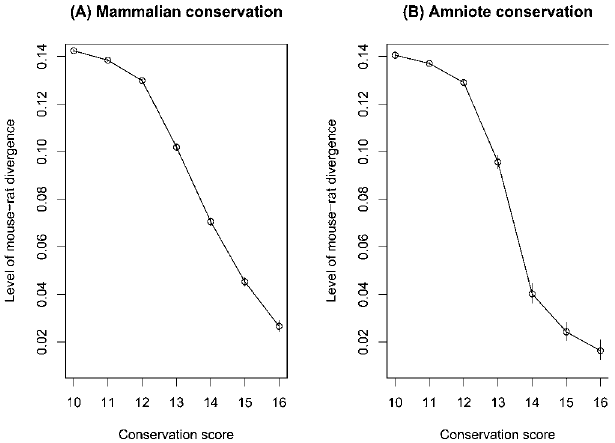
Figure 2. Levels of Mouse–Rat Divergence for Different Conservation Scores Conservation scores are calculated using human–mouse–dog three-way comparisons (A) or human–mouse–chicken comparisons (B). Error bars